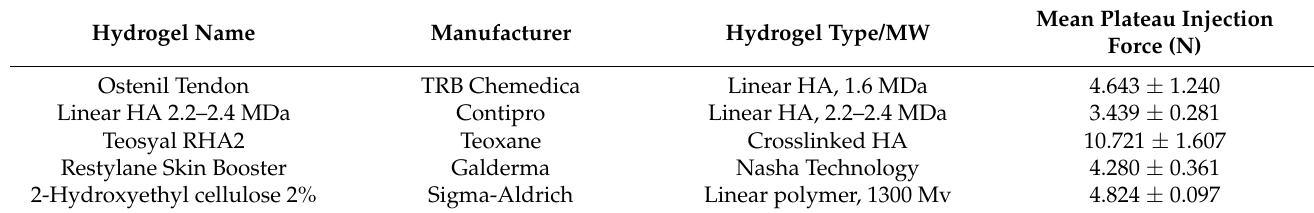
Table 4. Average injection force required to extrude the stabilized whole-cell extracts resuspended (i.e., at 10 6 cell equivalents/mL) in various commercial hydrogel products and reference hydrogels. The mean values are presented for each group and each assay condition, along with the